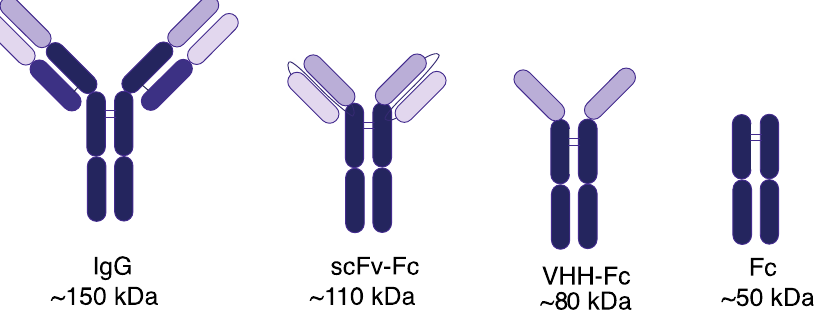
Figure 1. Fc-containing imaging probes. Probes used for this study are an IgG (~150 kDa), a scFv-Fc (~110 kDa), a VHH-Fc (~80 kDa), and an Fc domain (~50 kDa). An IgG is comprised of a light chain and heavy chain. Antigen binding is mediated by complementarity-determining regions found in the variable domains of the light chain (light grey) and heavy chain (dark grey). Constant domains and the crystallizable fragment (Fc) are shown in black.